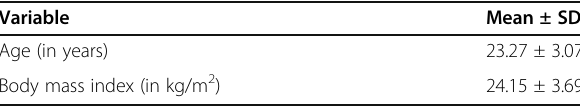
Table 1 Demographic characteristics of the participants